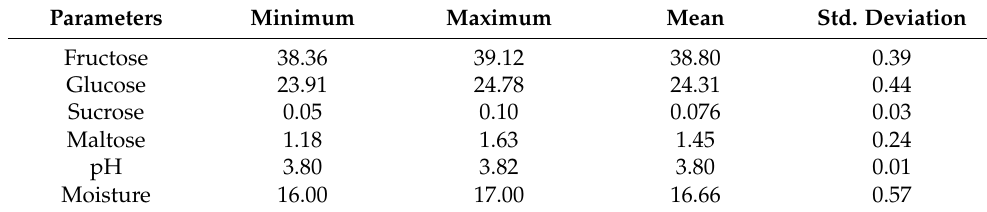
Table 1. Analysis of physicochemical properties of